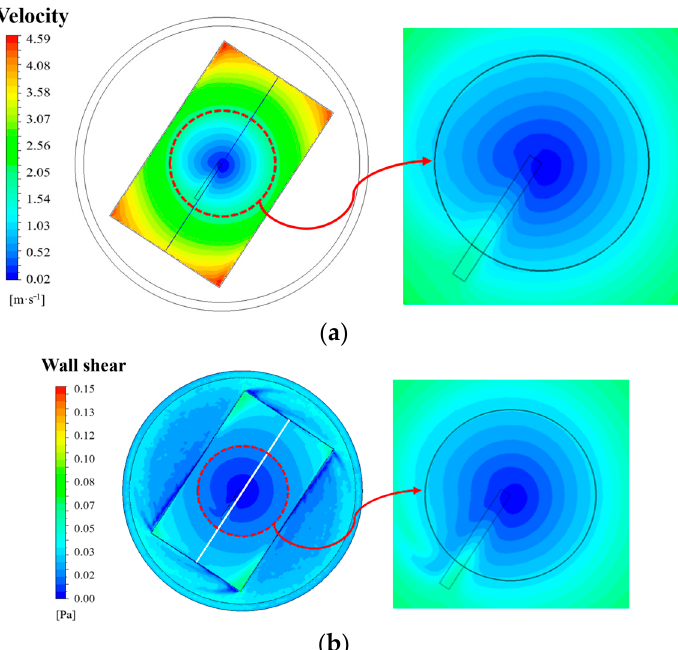
Figure 5. The contour map of the velocity and wall shear distribution in the reference group and the airflow disturbance group. ( a ) the velocity distribution, ( b ) the airflow shear stress distribution. Details within the dashed line are magnified in the contour map on the right.